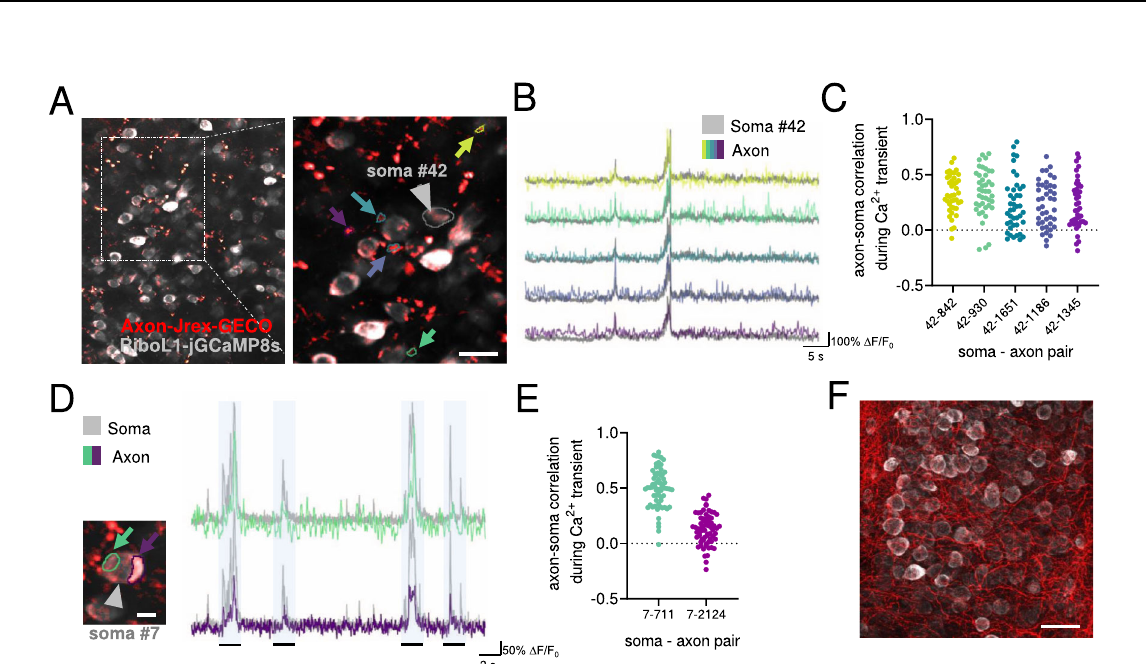
Fig. 5 | Baseline brightness, signal-to-noise, and cell density quanti fi cation. A Pearson correlation coef fi cients of somatic to neuropil signals of RO or IC administered GCaMP. B Baseline (median) fl uorescence intensity. C Soma over neuropil baseline (median) fl uorescence intensity. A – C n =4 mice per GECI for RO injections,3miceperGECIforICinjections;alldatapointsindicateindividualcells, lines indicate population means. D Number of ROIs detected per fi eld of view in Cellpose. Each data point indicates one FOV from one mouse, line indicates